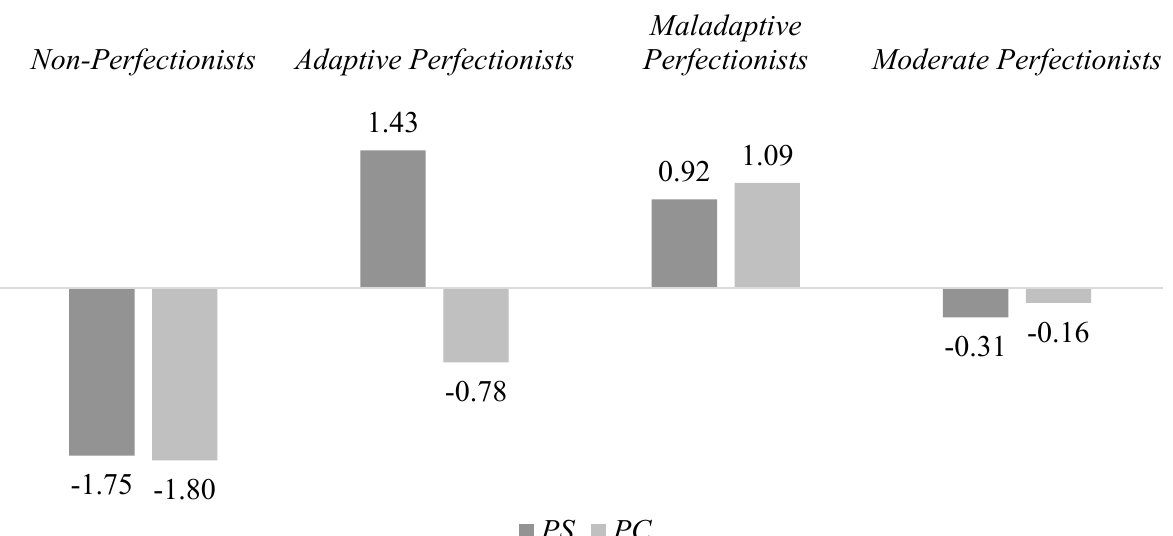
Figure 1. Graphic representation of the standardized average scores for the model of the latent classes (adapted from Vicent et al.